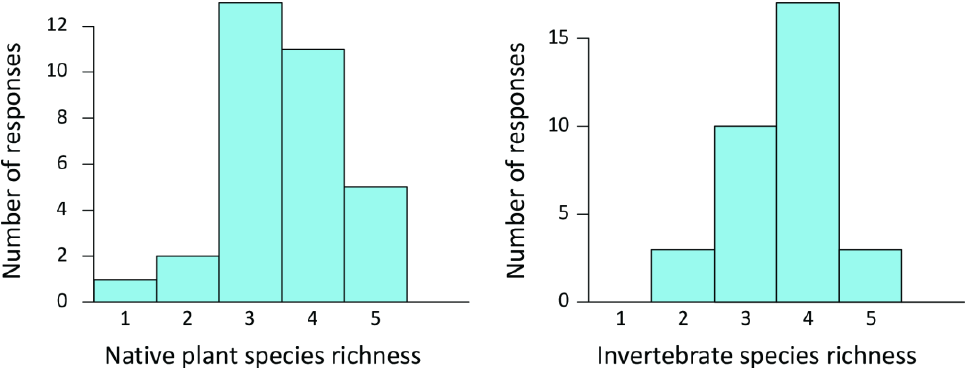
Figure 2. Garden owners’ perceptions of species richness in their gardens. Responses to the questions “How high do you estimate the diversity of native plants in your garden to be?” and “How high do you estimate the diversity of invertebrates in your garden to be?” by interviewed garden owners. Answers were given on a scale ranging from 1: “very low” to 5: “very high”. One owner did not rate plant richness.